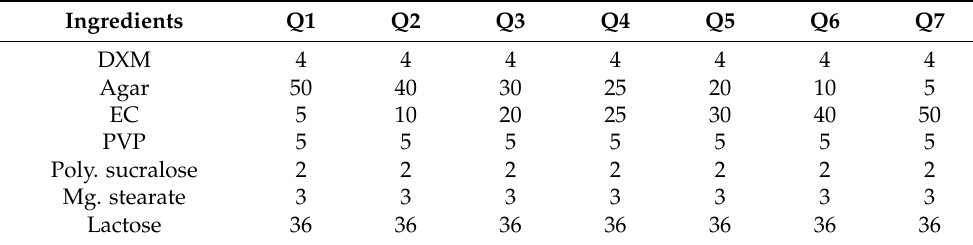
Table 1. Composition (%, w / w ) of compressed mucoadhesive